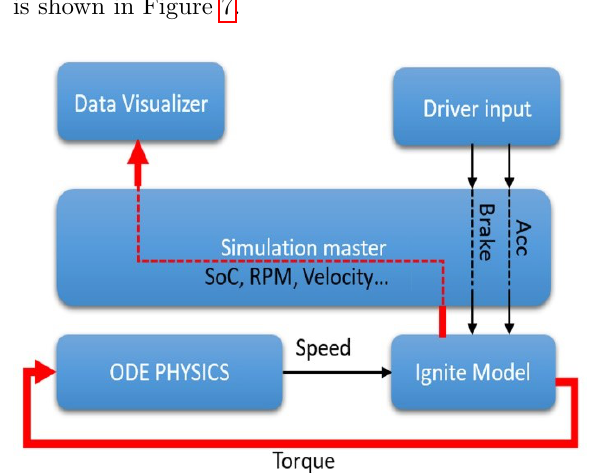
Figure 7. Simulation